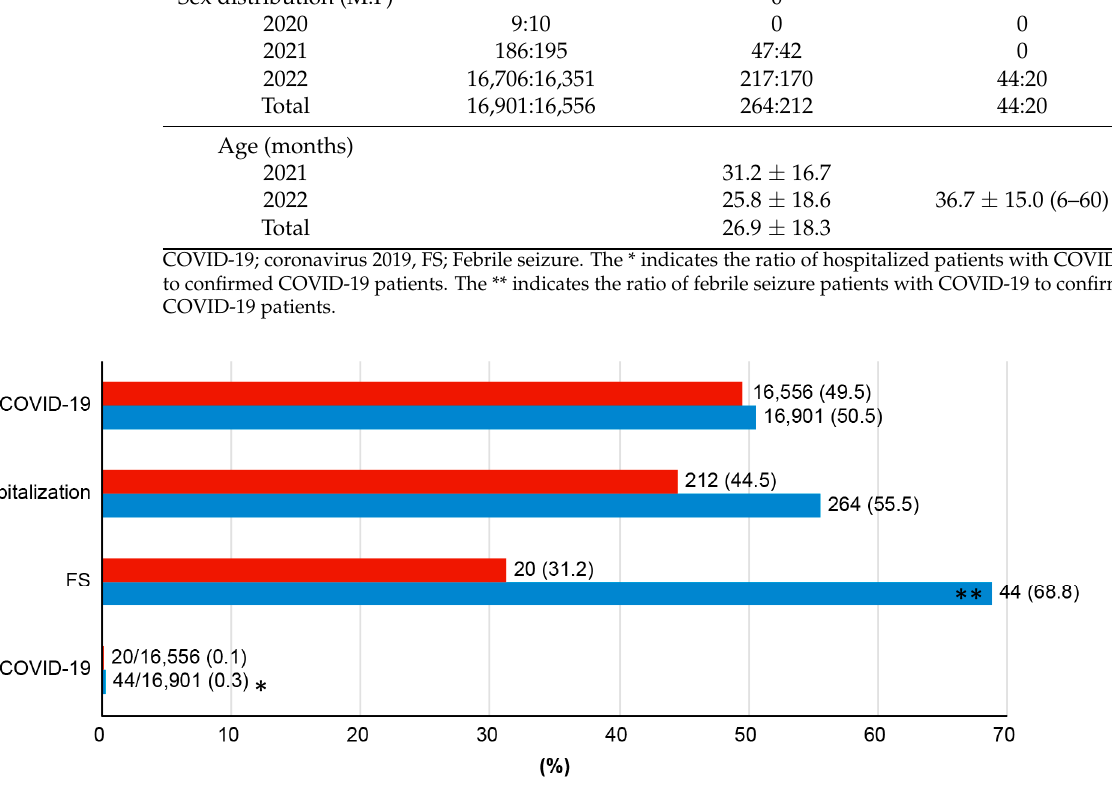
Figure 2. Incidence of confirmed COVID-19 cases, febrile seizures, and hospitalization rates according to year during the COVID-19 pandemic. The * indicates the percentage of boys with febrile seizures among those with confirmed COVID-19. The ** indicates the percentage of boys among those who showed febrile seizures Table 1. Demographic features of children with coronavirus 2019 in Jeonbuk.